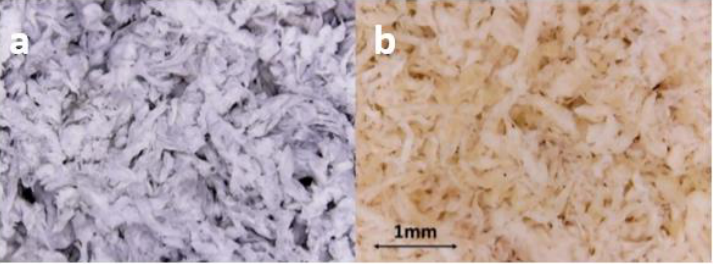
Figure 7. Micrographs of the leather shavings used: ( a ) Chrome-tanned (C), tanned from the wet blue industrial process; and ( b ) chromium-free (NC), from the wet white industrial process.